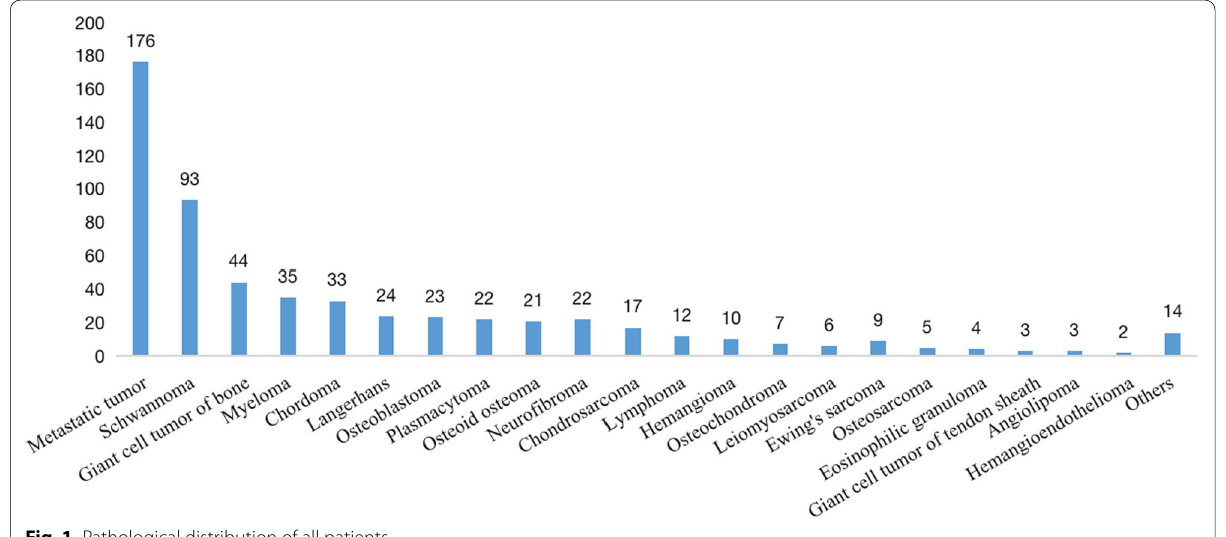
Fig. 1 Pathological distribution of all patients